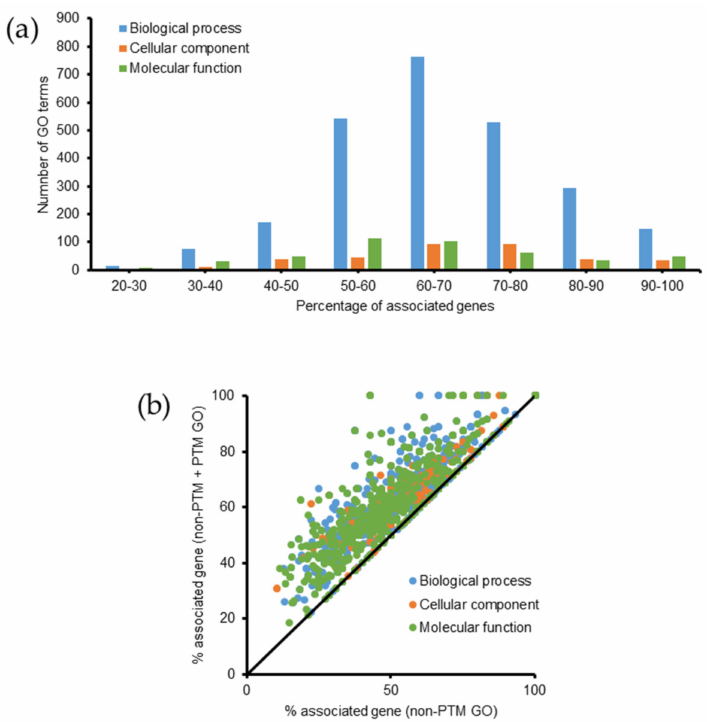
Figure 4. Summary of gene ontology analysis in Emiliania huxleyi using ClueGO. Lists of proteins from the non-PTM and PTM datasets were used for the analysis. ( a ) Summary of the number of GO terms according to the percentage of associated genes. ( b ) Increase in the percentage of associated genes after performing PTM